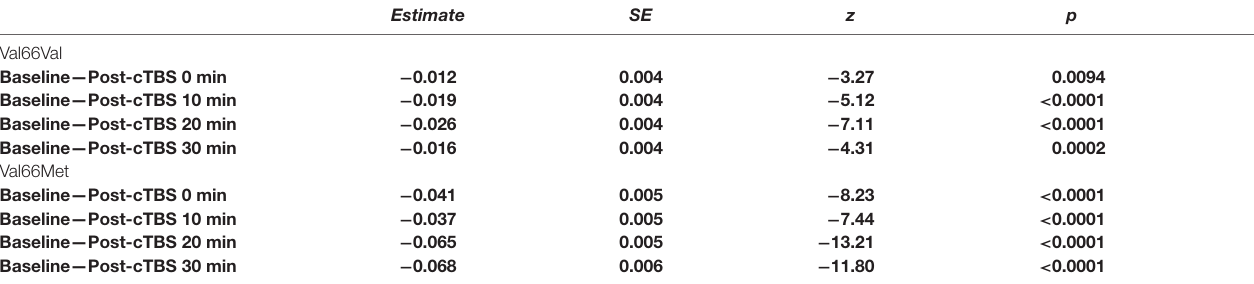
TABLE 4 | Post hoc comparison results assessing the change in MEPs from baseline to post-cTBS time points within each BDNF genotype group as a function of SI.